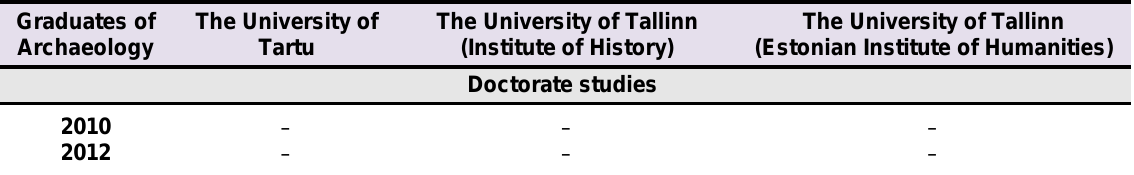
Table 15 - The graduates of Doctorate studies in 2010 and